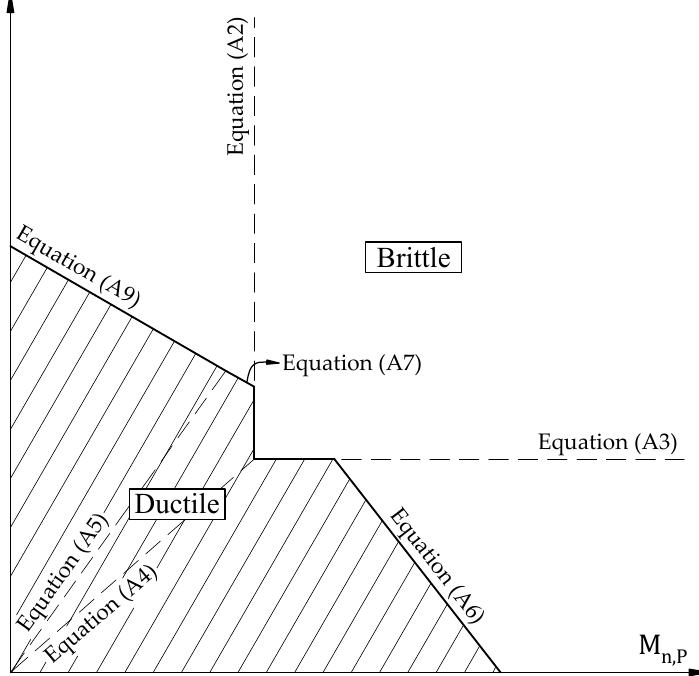
Figure 4. Limit failure regions for a continuous slab with the same clear span.